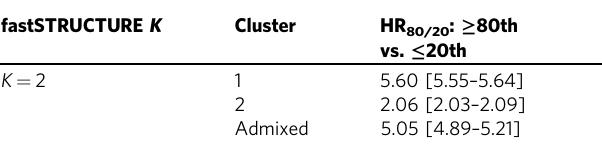
Table 5 Association of PHS with aggressive prostate cancer, by two clusters using